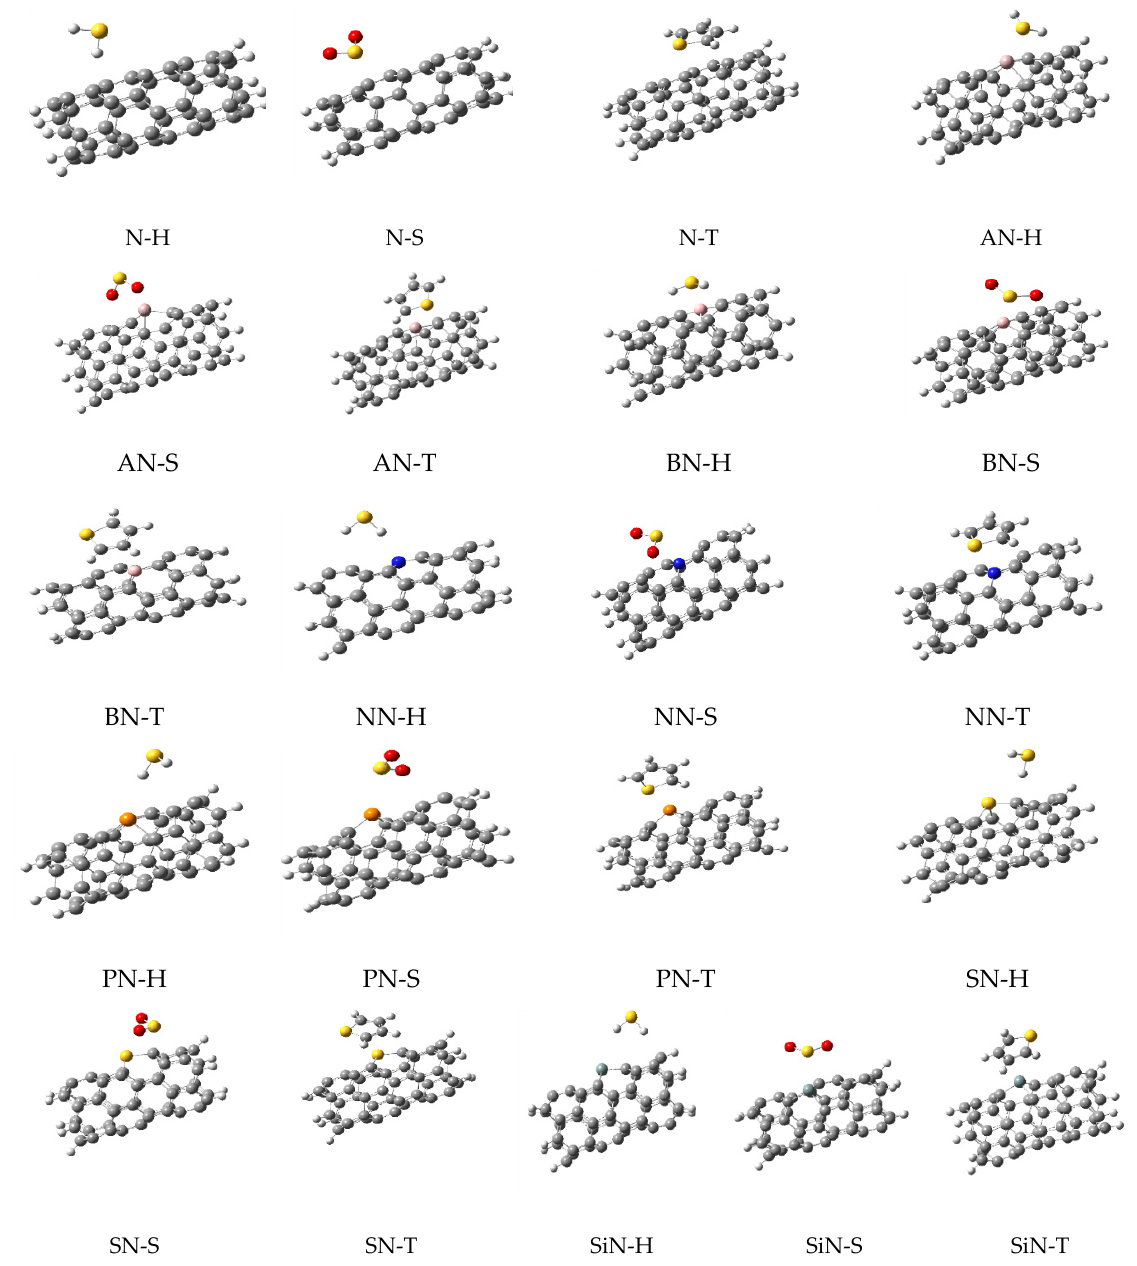
Figure 2. The optimized structures for all complexes of nanotubes with H 2 S, SO 2 , and thiophene.